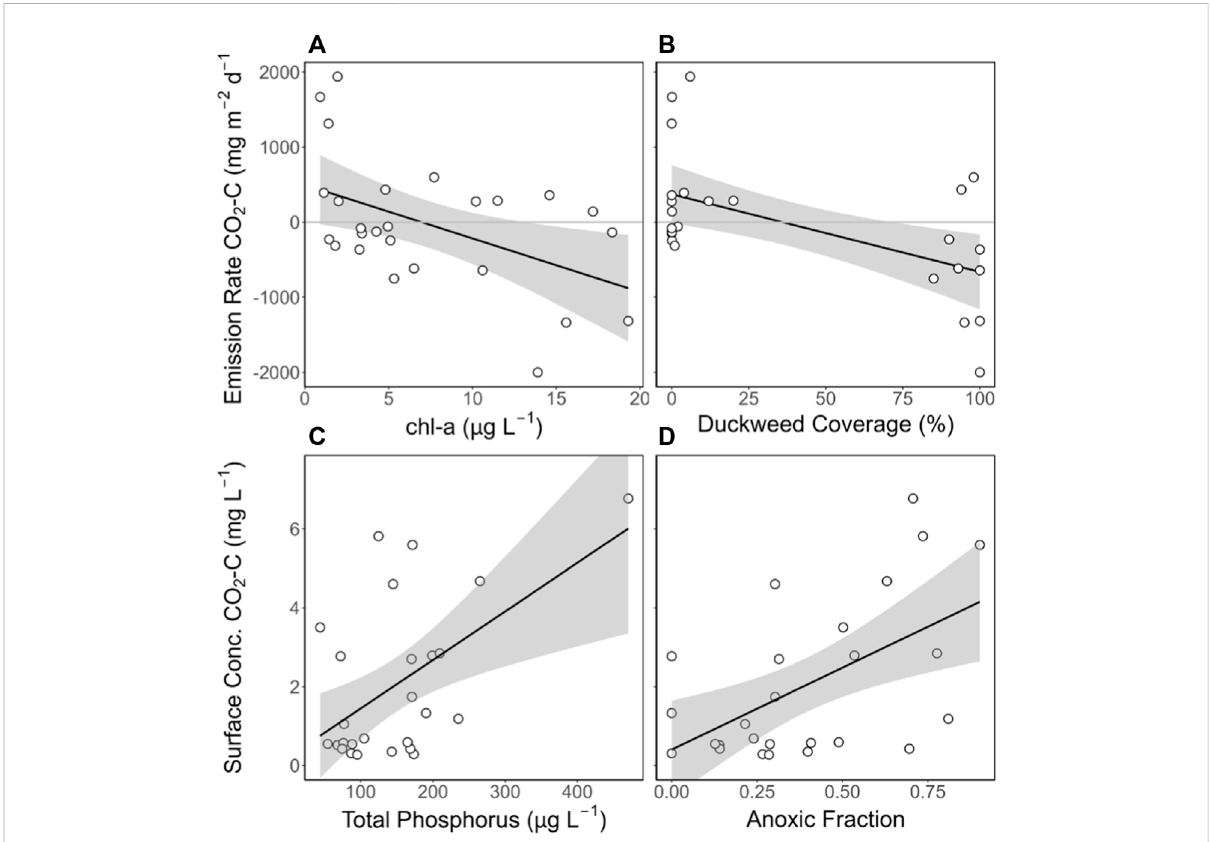
FIGURE 1 CO 2 emissions from the fl oating chamber and CO 2 surface concentrations were signi fi cantly correlated with different variables. Scatterplots show signi fi cant correlations for all ponds (n = 26) between (A) CO 2 emission rate and chl-a (y = -71.28 + 496.25, R 2 = 0.22, p = 0.016) (B) CO 2 emission rate and duckweed coverage (y = -10.34 + 371.83, R 2 = 0.31, p = 0.0033) (C) CO 2 surface concentration and total phosphorus (y = 0.01x + 0.21, R 2 = 0.30, p = 0.0039), and (D) CO 2 surface concentration and anoxic fraction (y = 4.15x + 0.41, R 2 = 0.38, p =